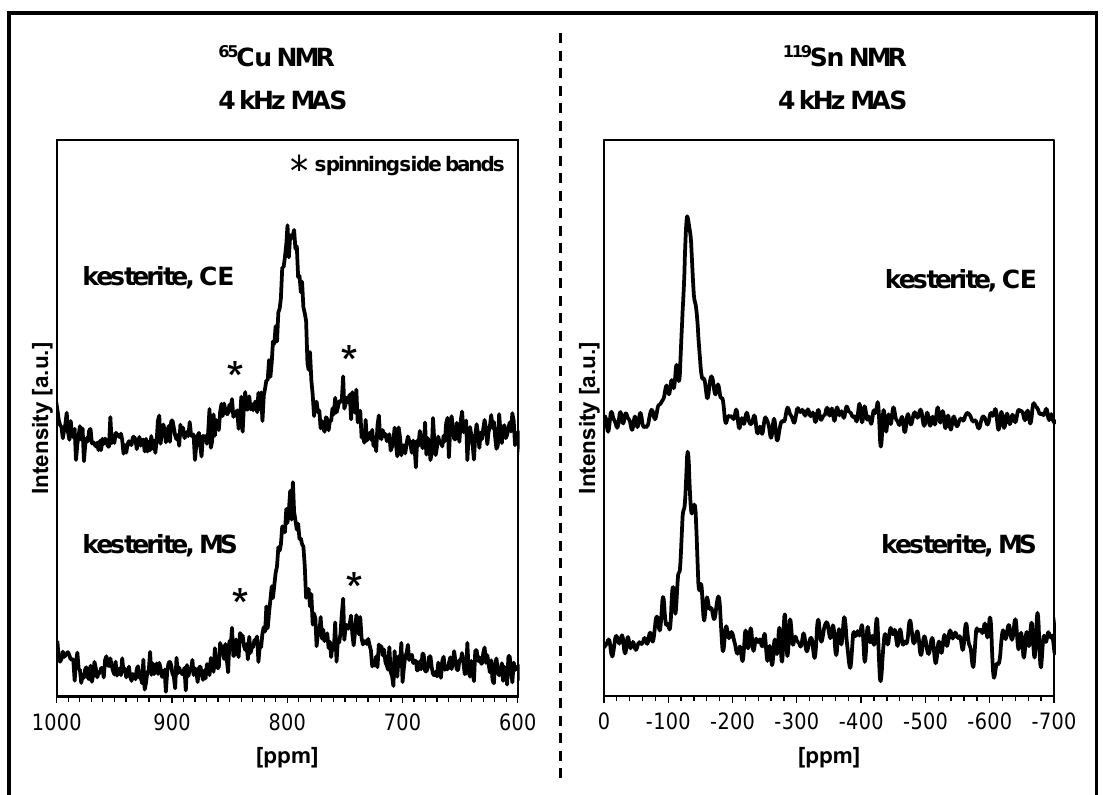
Figure 5. Solid-state MAS NMR spectra for kesterite nanopowders: ( left )— 65 Cu NMR, ( right )— 119 Sn NMR. In both sides, the upper spectra are for the CE system and the lower spectra are for the MS system.